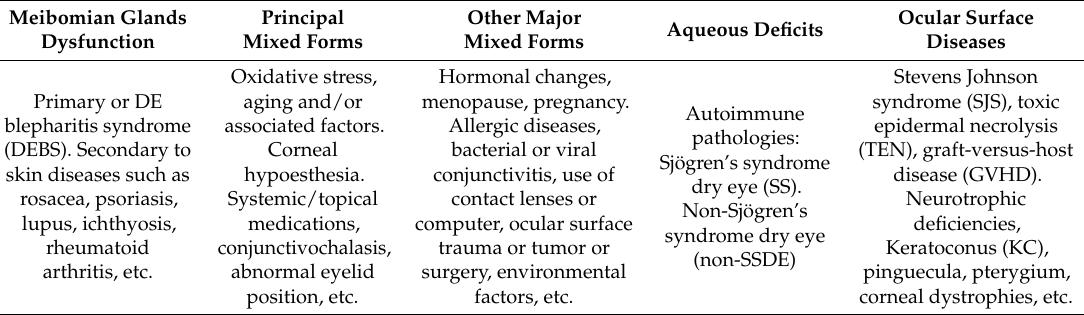
Table 2. Dry eye (DE) classification according to pathogenetic analysis in ocular surface disorders. Meibomian Glands